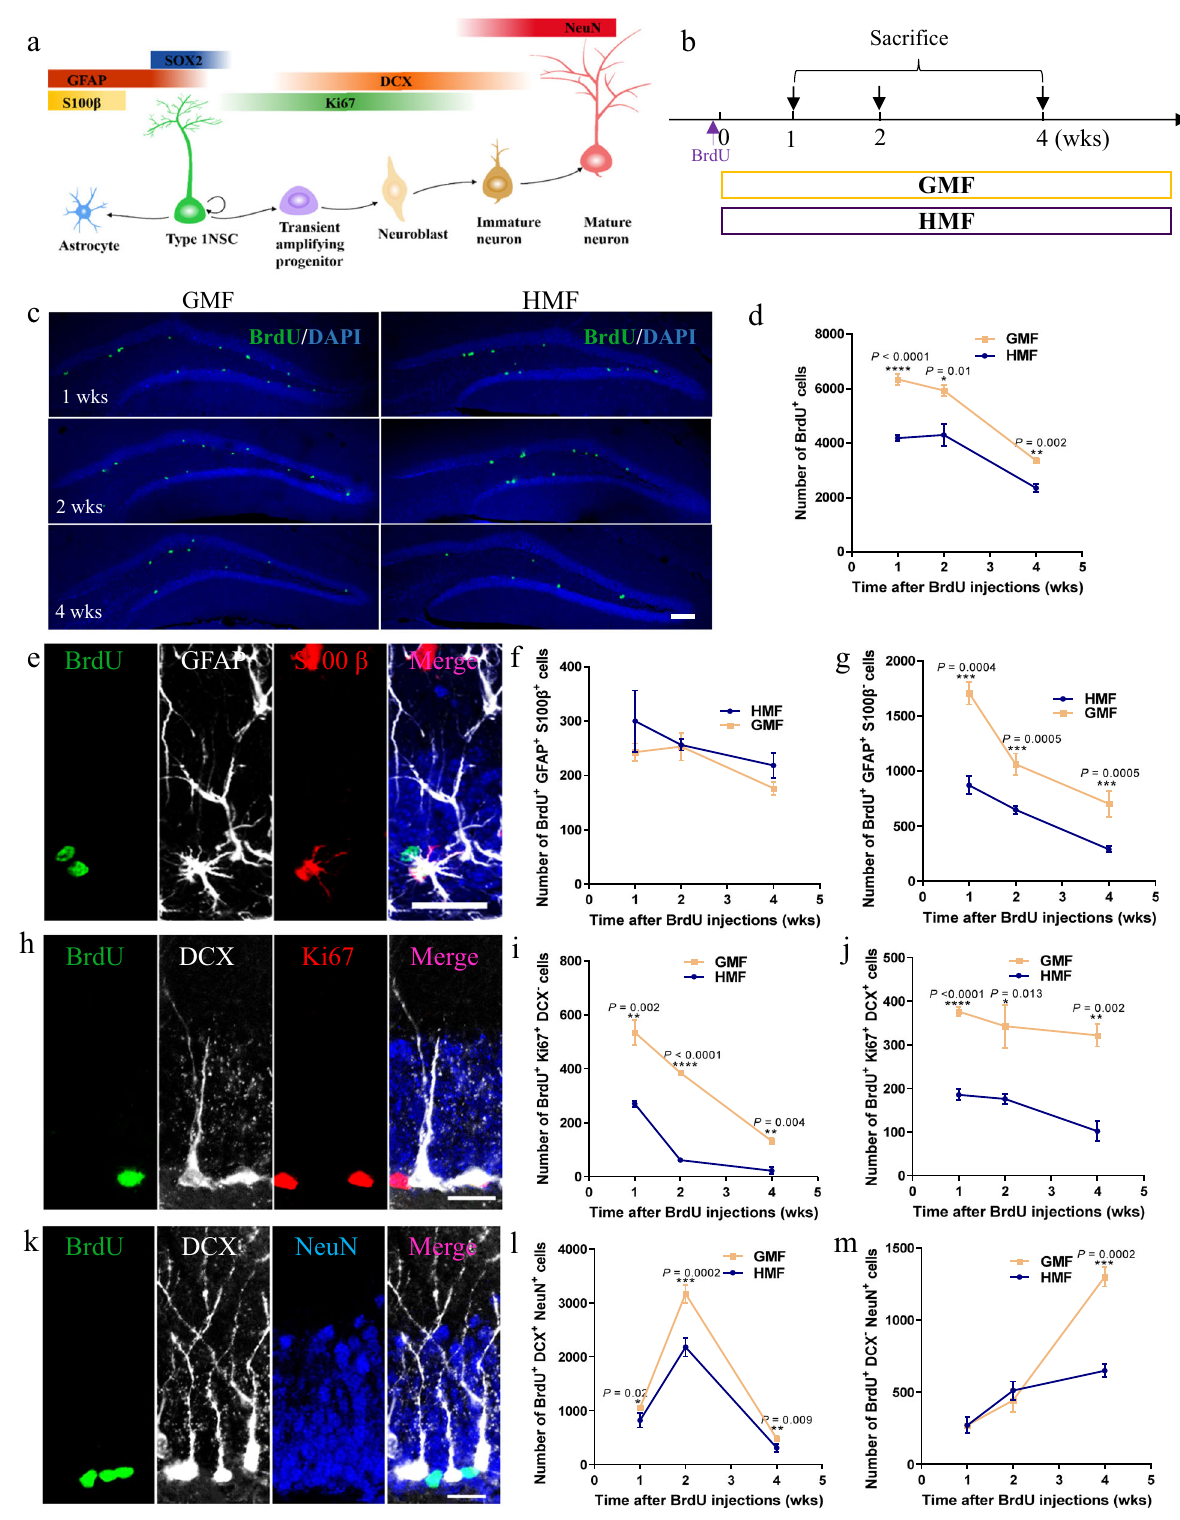
the dendritic development of newborn neurons. Retroviruses expressing red fl uorescent protein (RFP) were stereotactically injected into the DG of adult mice to label proliferating aNSCs and their progeny (Fig. 3a), and the RFP + newborn neurons were evaluated at 4-weeks post retrovirus injection during HMF exposure (Fig. 3b). Compared to GMF-exposed mice, RFP +